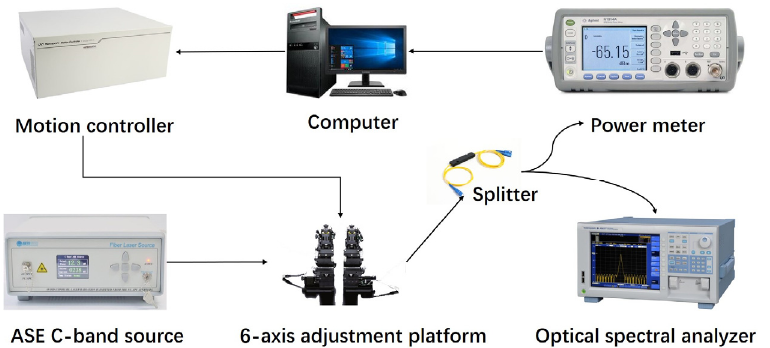
Figure 9. Testing system for the spectrum measurement of the fabricated AWG.